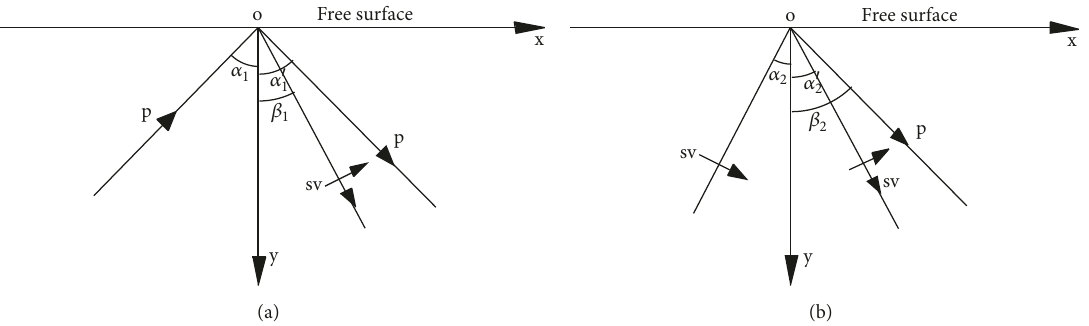
Figure 1: Reflection of obliquely incident waves on the free surface: (a) P wave and (b) SV